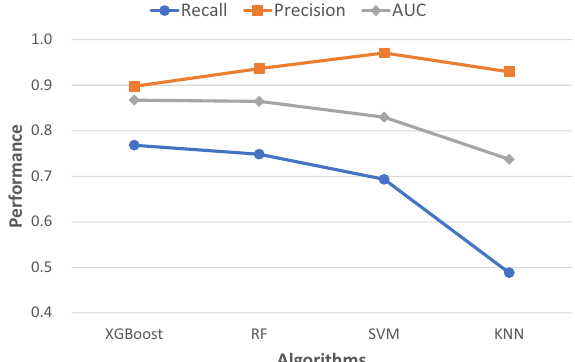
Figure 3. Initial performance comparison of different machine learning (ML) algorithms for lung cancer risk prediction. Base models of all algorithms used default settings of the corresponding classifiers. Model performances on a dataset of 30,000 patients and 50 variables were measured by recall, precision and AUC.